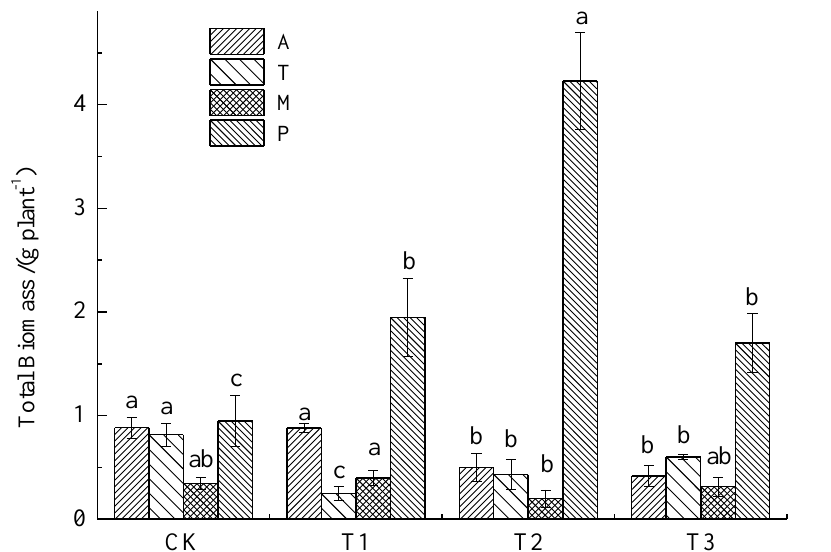
Figure 3. Total biomass of native plant species under different treatments in Pb-polluted soil. Means ± SE with different letters indicate significant differences according to LSD testing ( p < 0.05).